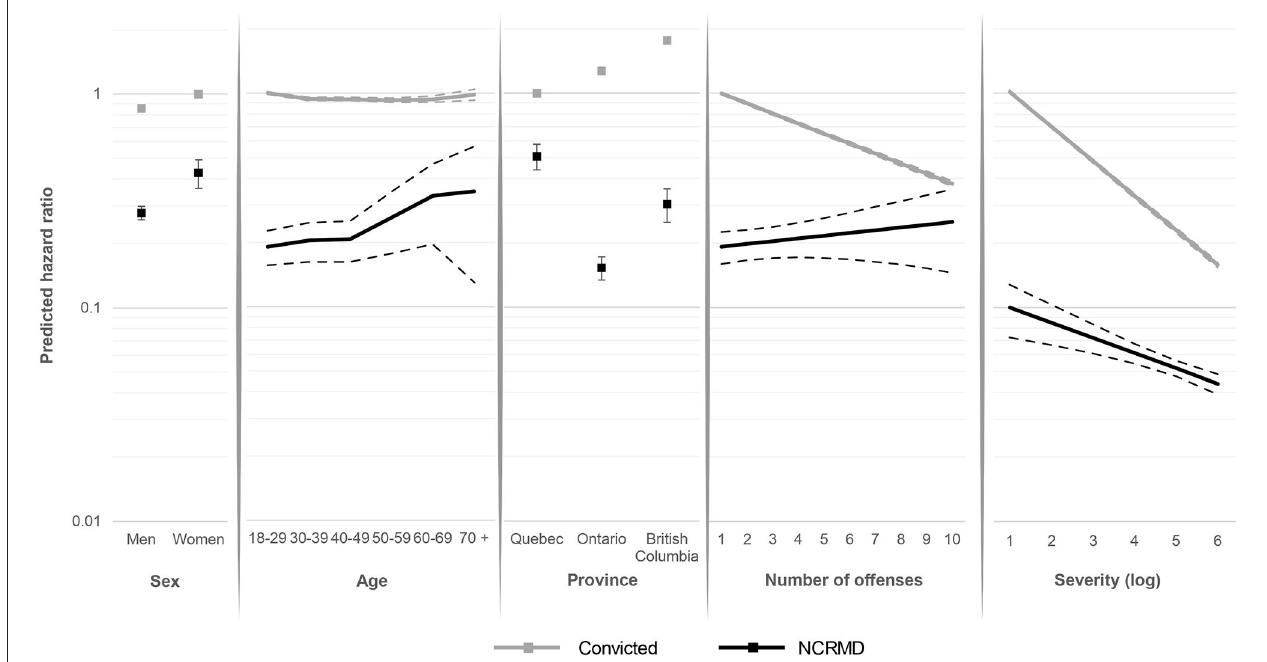
FIGURE 4 | Predicted odds of being released from supervision over time for NCRMD and convicted offenders by sex, age, province, number of offenses, and offense severity a . – Represent confidence